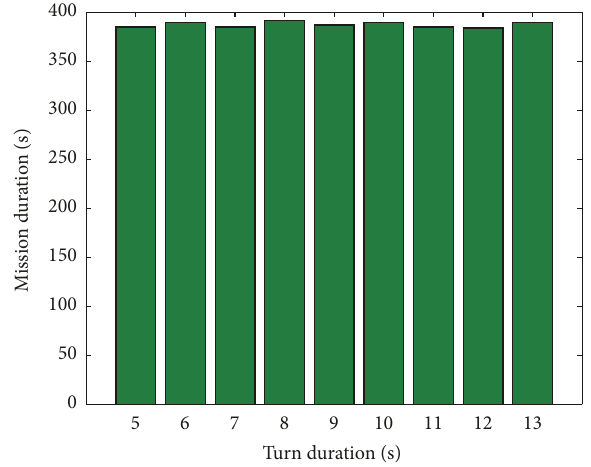
Figure 15: Actual mission duration for time constraint based formulation with power consumption dependent on the